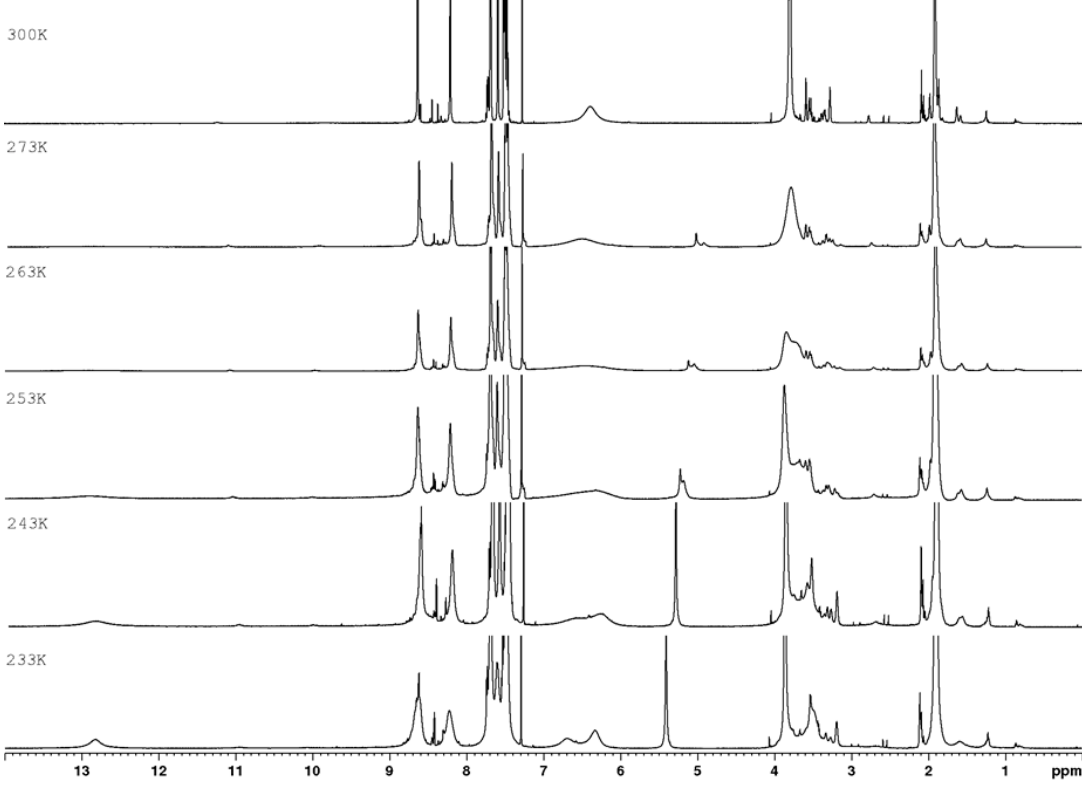
Figure 3. 1 H NMR spectra of 1a as a function of temperature (700 MHz, CDCl 3 ).